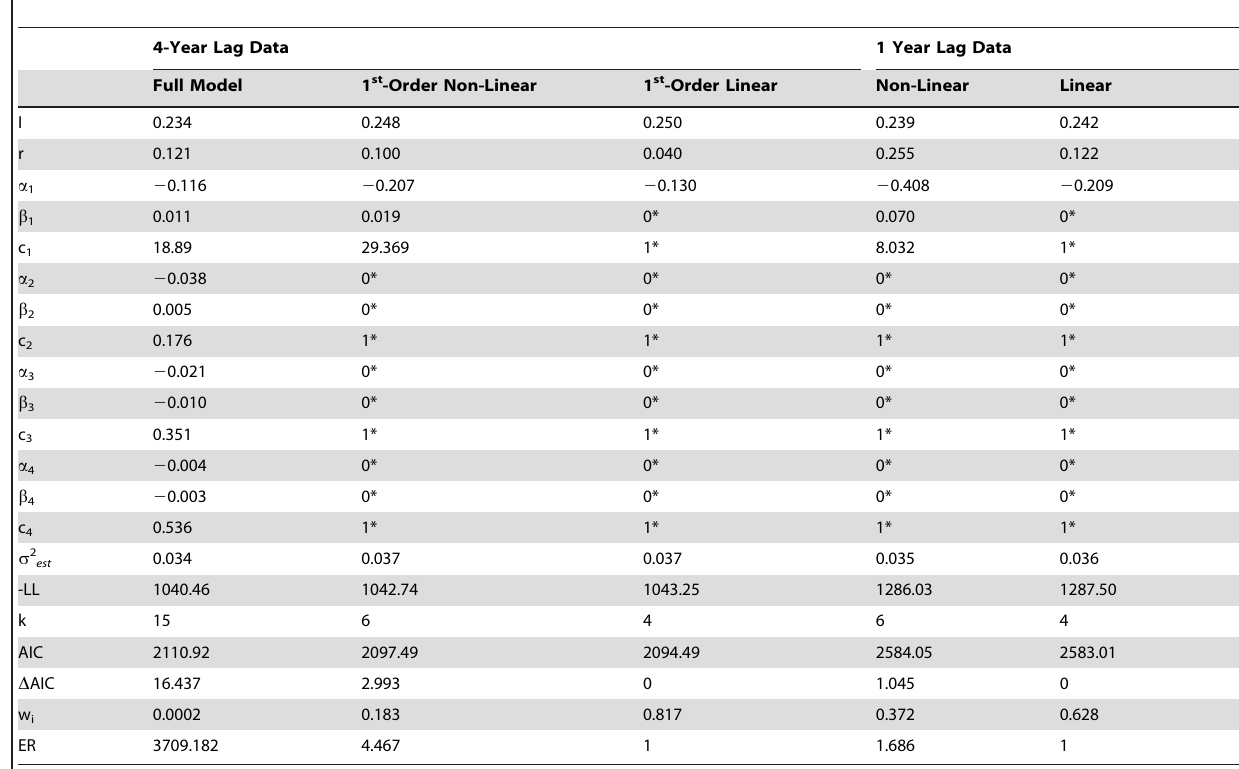
Table 1. Maximum likelihood estimates of parameters for constant-variance models of mussel